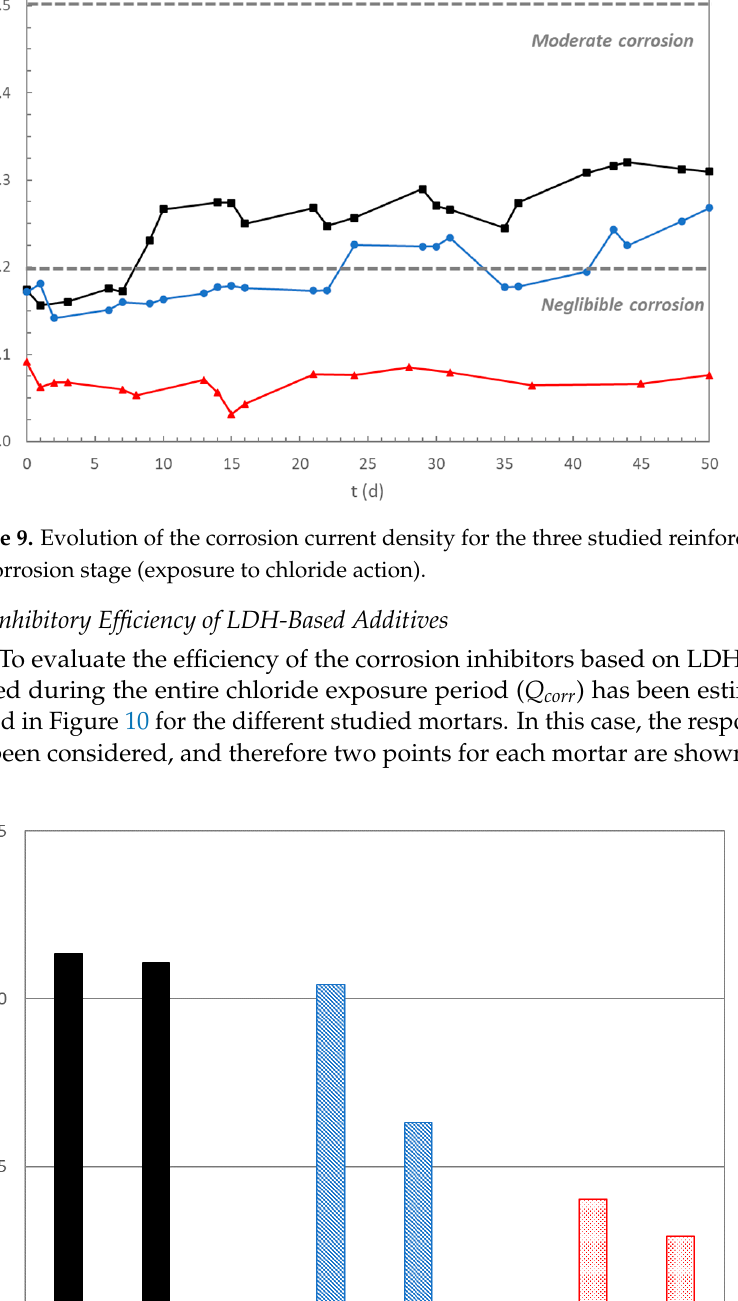
Figure 9. Evolution of the corrosion current density for the three studied reinforced mortars during the corrosion stage (exposure to chloride action).